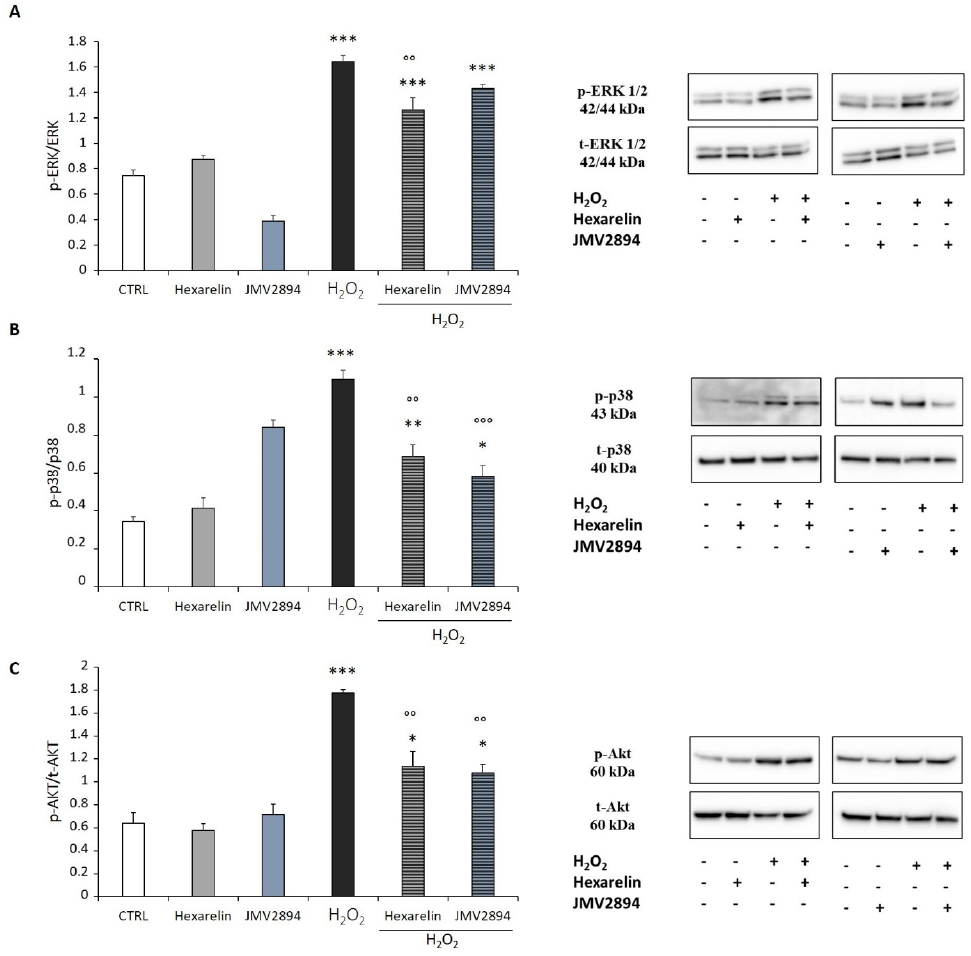
Figure 10. GHS modulate ERK, p38 and Akt activation. SH-SY5Y SOD1 G93A cells were treated with or without GHS and H 2 O 2 for 24 h and western blot assay was used to measure ( A ) p-ERK/t-ERK, ( B ) p-p38/t-p38, and ( C ) p-Akt/t-Akt ratios. All assays were performed in 3 independent experiments. Statistical significance: * p < 0.05, ** p < 0.01, and *** p < 0.001 vs. CTRL; ◦◦ p < 0.01, and ◦◦◦ p < 0.001 vs. H 2 O 2